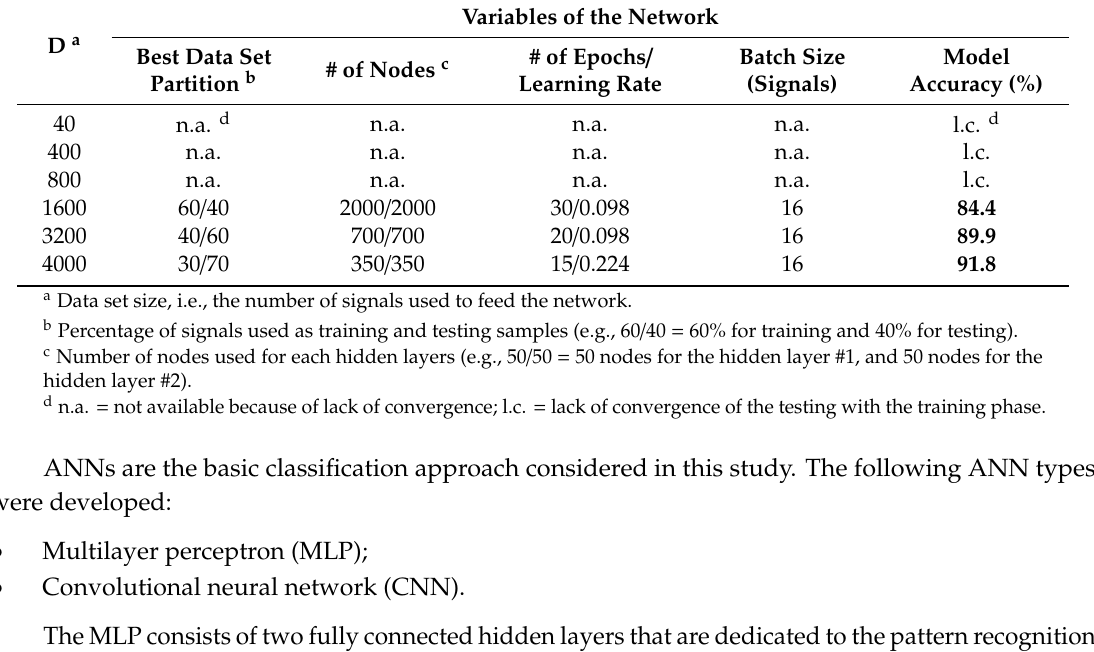
Table 1. Multilayer perceptron (MLP): best results.